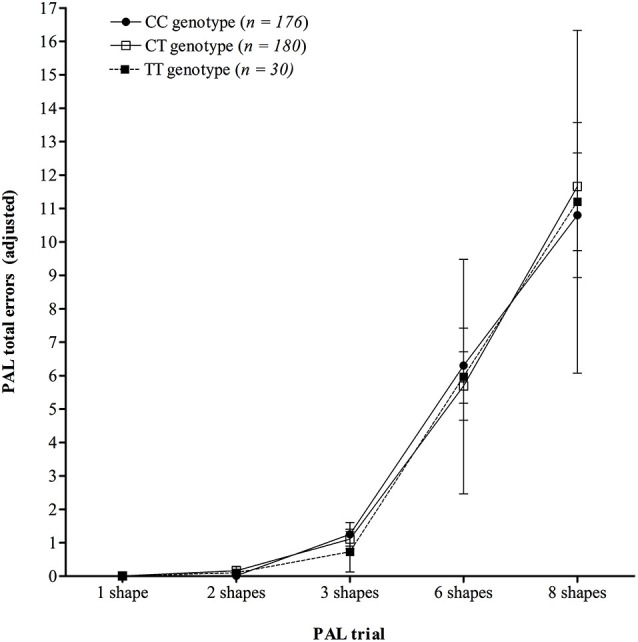
Mean number of total errors made across trials on the PAL test, showing no significant interaction between KIBRA genotype. Error bars display 95% confidence intervals.